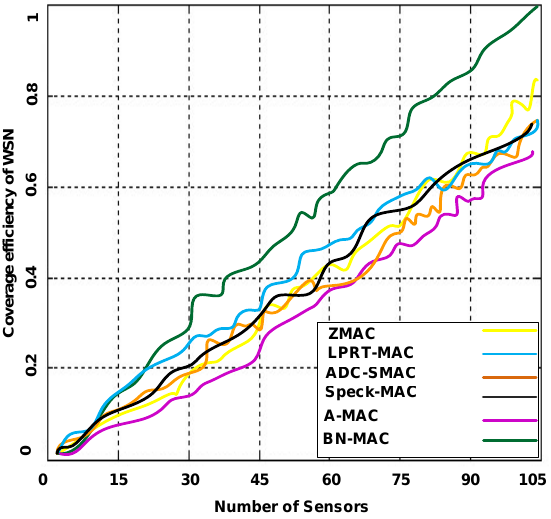
Figure 14. Coverage efficiency of the WSN using a different number of sensor nodes.